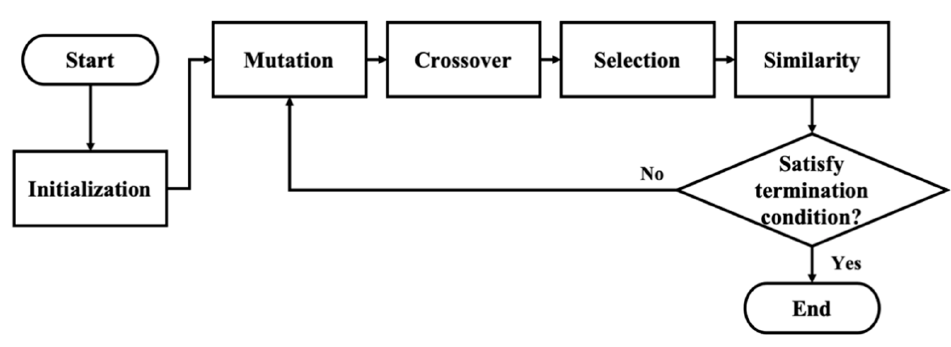
Figure 12. Flow chart of the MDE algorithm.